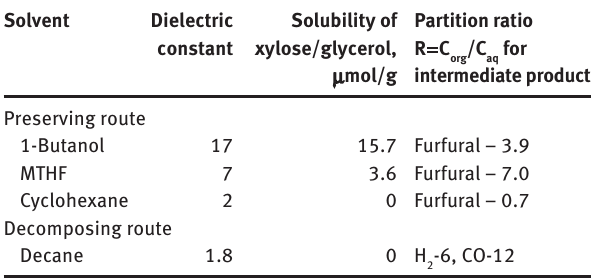
Table 1: Dielectric constants, solubility of biomass derived prod- ucts, and partition ratio of intermediate products for both preserv- ing and decomposing